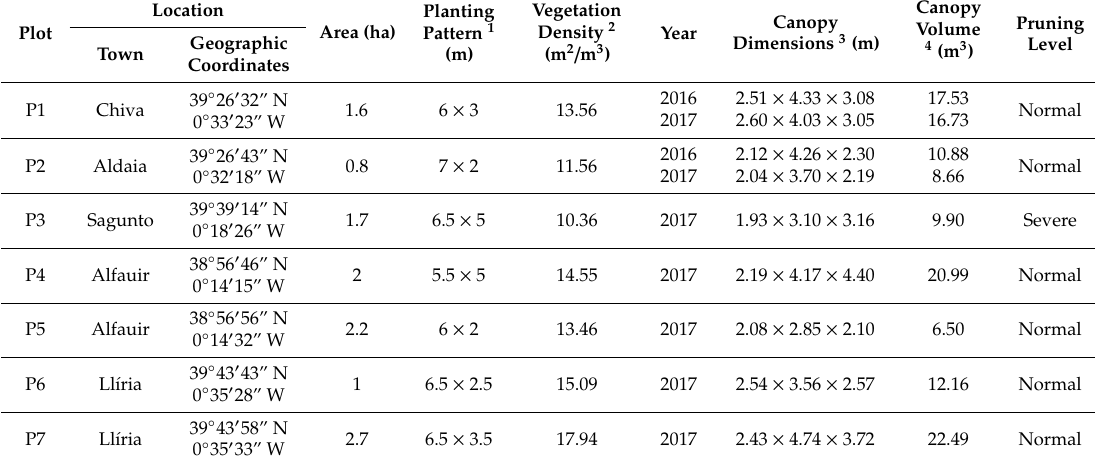
Table 1. Characteristics of trial orchards.